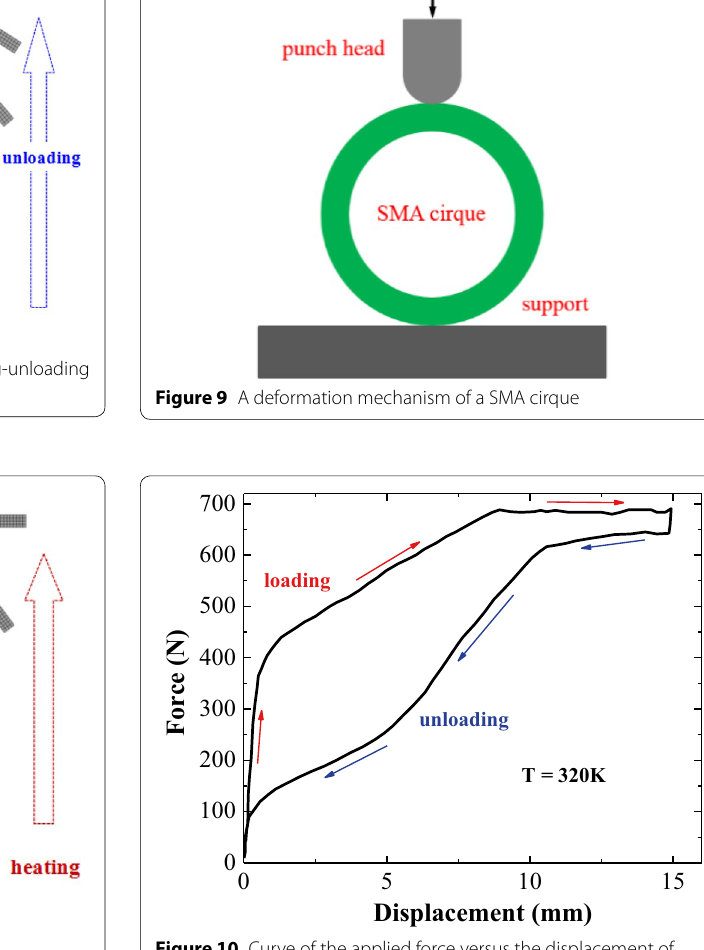
Figure 10 Curve of the applied force versus the displacement of punch head at 320